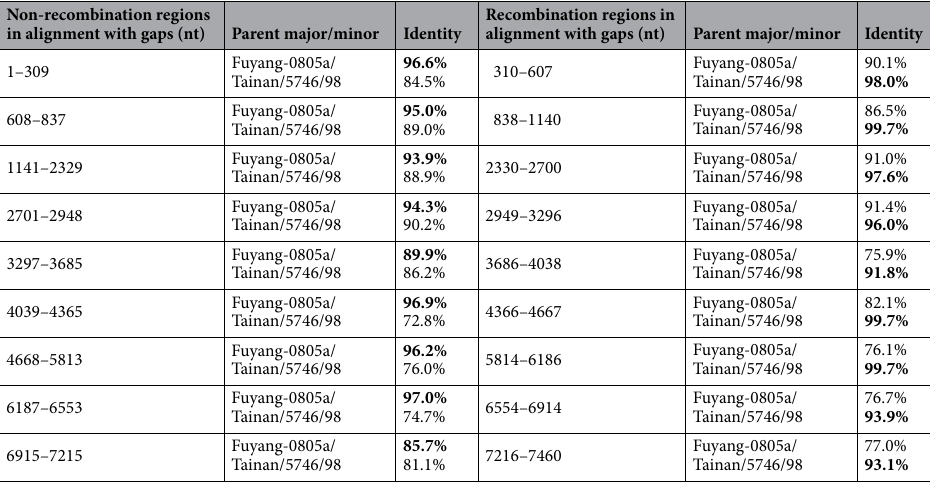
Recombination regions in alignment with gaps (nt) Parent major/minor